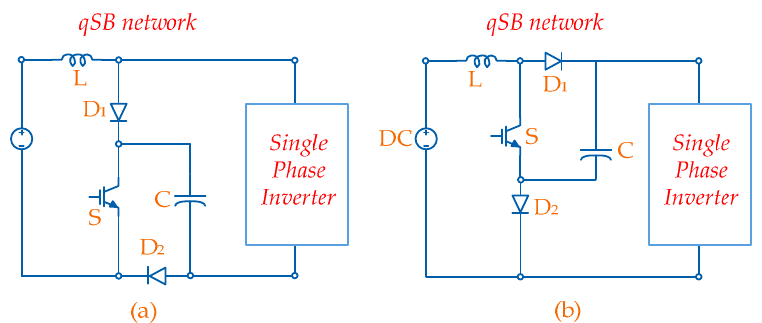
Figure 3. Embedded quasi-switched boost inverter (SBI) topologies. ( a ) Type 1; ( b ) Type 2.